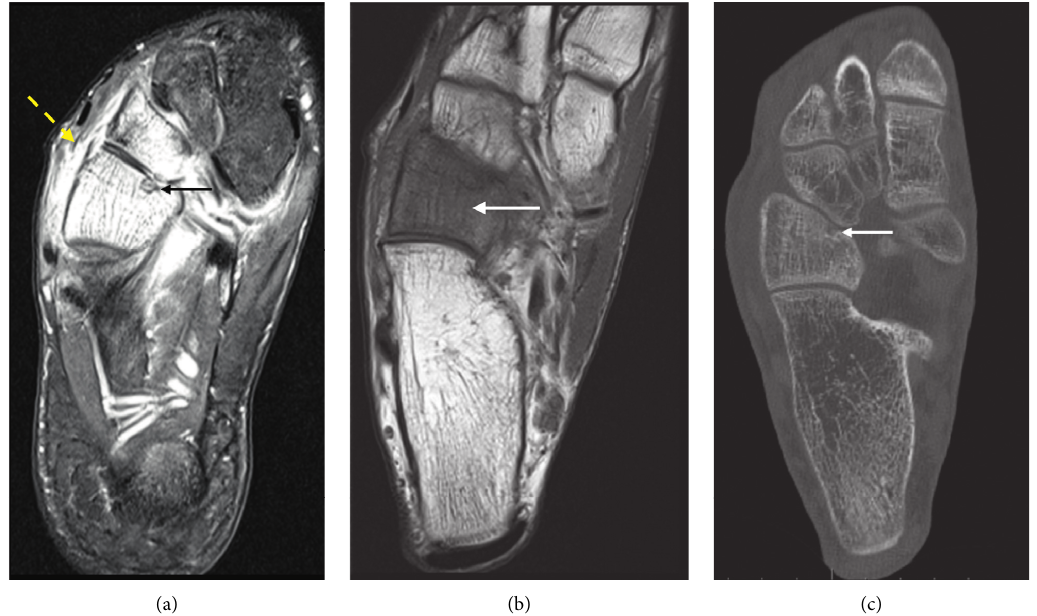
Figure 11: Cuboid osteoid osteoma in a 17-year-old presenting with a 2-month history of foot pain. Axial PDFS (a) of the foot shows diffuse marrow oedema-signal in the cuboid and lateral cuneiform with adjacent synovitis and soft tissue oedema. There is T1 marrow replacement of the cuboid ((b), arrow). A fluid-hyperintense nidus, best seen on the fluid-sensitive sequence, is noted in the medial border of the cuboid, with extension into the articular surface (arrow), accounting for the effusion and reactive synovitis (A yellow dash). The nidus is confirmed on the CT ((c), arrow), demonstrating central calcification, and distinguishes the diagnosis of osteoid osteoma from infection.